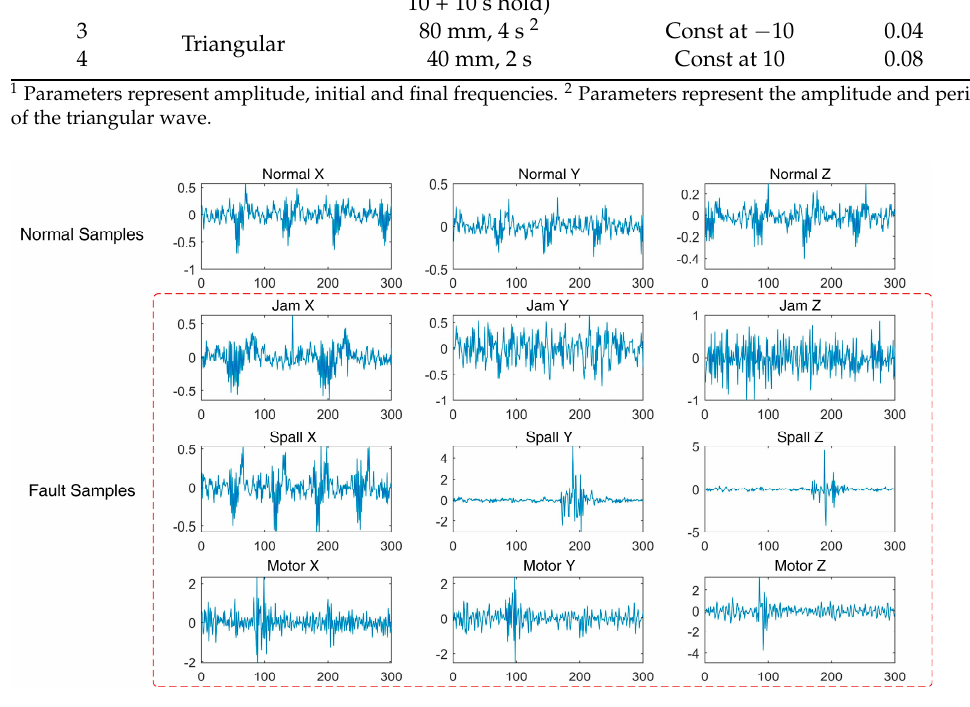
Table 1. Description of the case study dataset.